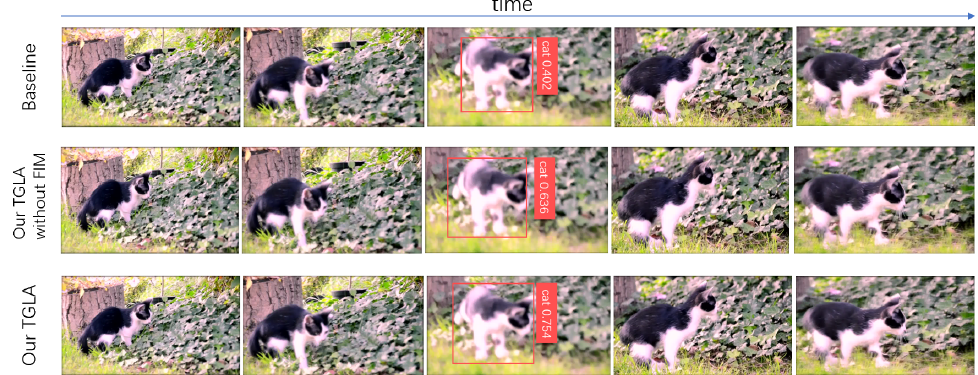
Figure 5. Comparison of detection results of different models for hard